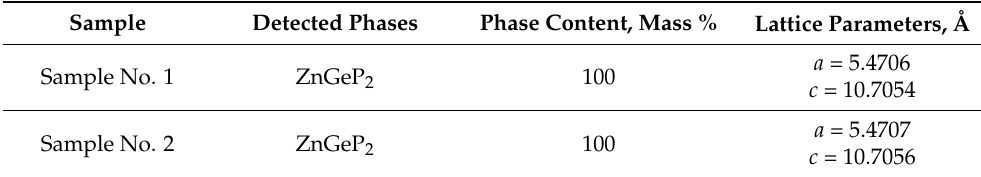
a = 5.4706 c = 10.7054 a = 5.4707 c =